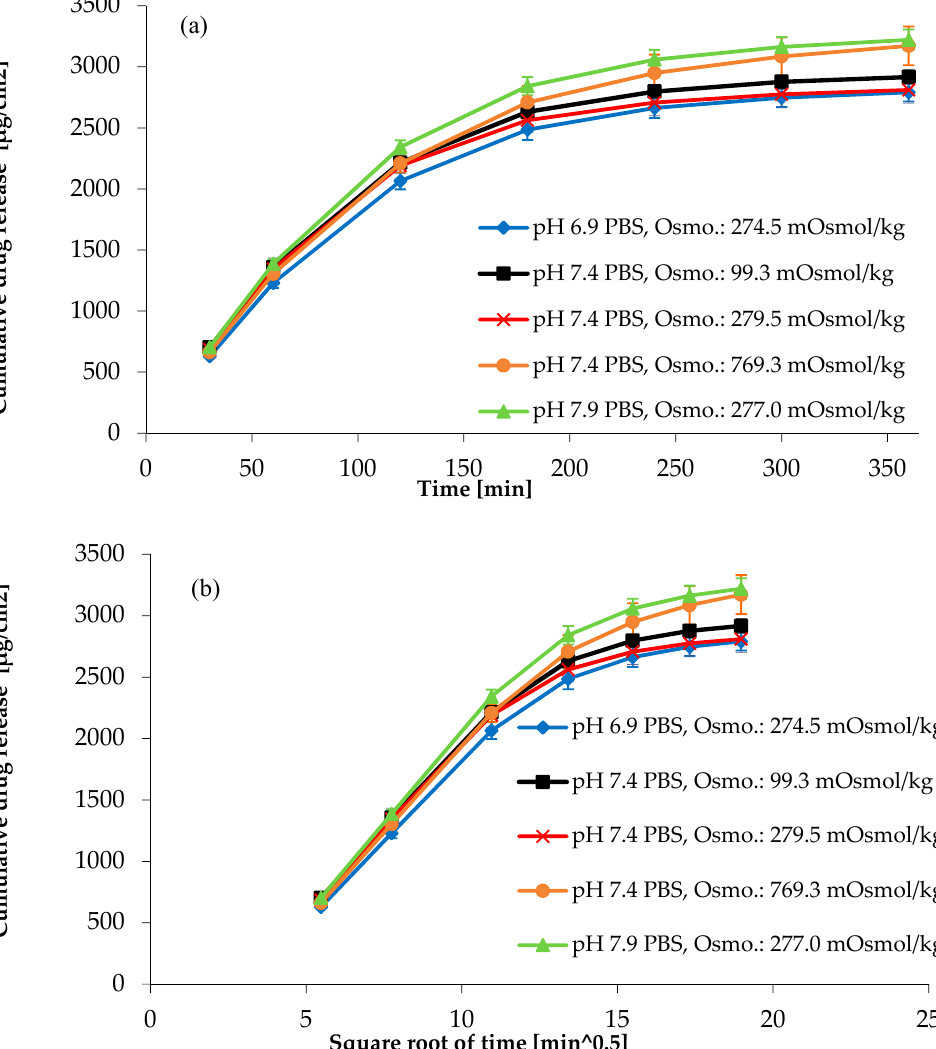
Figure 4. ( a ) Cumulative drug release per unit area in linear time scale, ( b ) cumulative drug release per unit area plotted against square root of time. Instrument: USP apparatus IV.